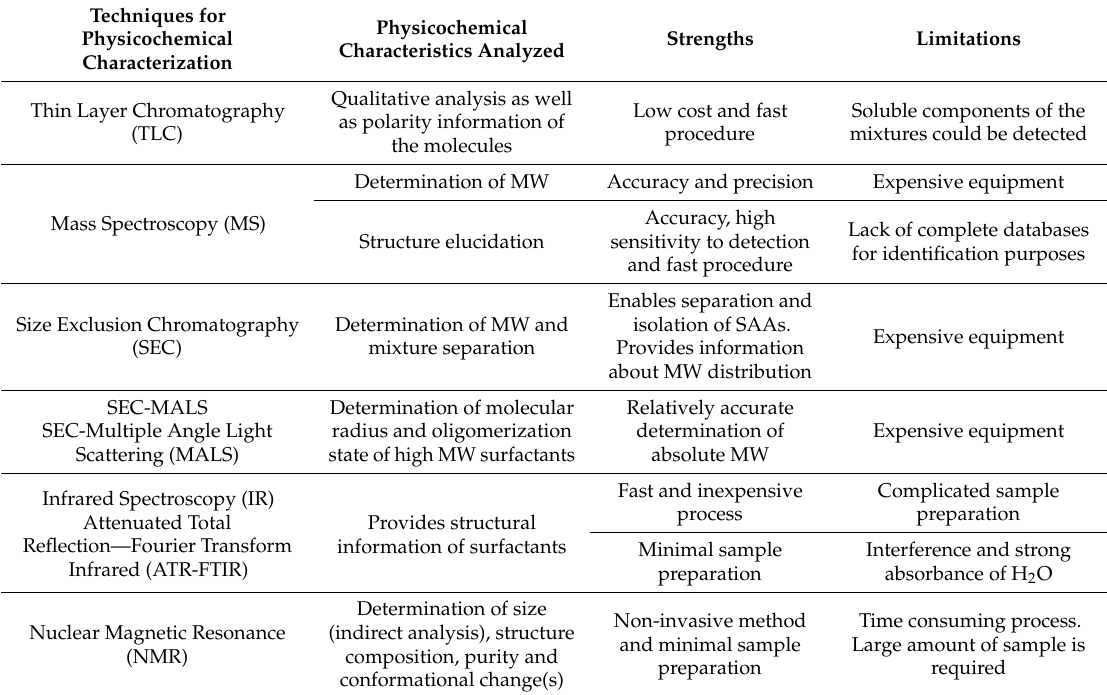
Table 1. Analytical approaches for evaluating the physicochemical characteristics of